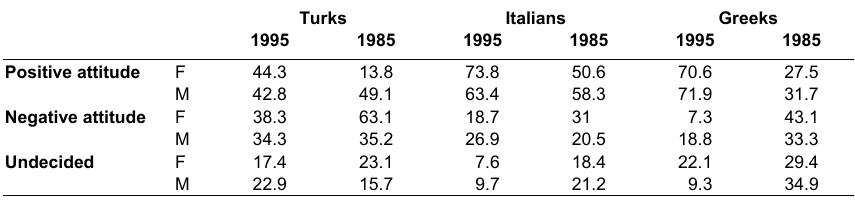
Willingness of unmarried foreign women and men to marry a German (percentages) Turks Italians Greeks 1995 1985 1995 1985 1995 1985 Positive attitude F 44.3 13.8 73.8 50.6 70.6 27.5 M 42.8 49.1 63.4 58.3 71.9 31.7 Negative attitude F 38.3 63.1 18.7 31.0 7.3 43.1 M 34.3 35.2 26.9 20.5 18.8 33.3 Undecided F 17.4 23.1 7.6 18.4 22.1 29.4 M 22.9 15.7 9.7 21.2 9.3